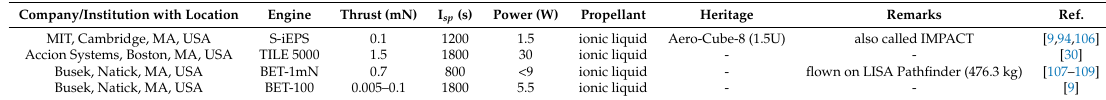
Table 7. Summary of Electrospray Propulsion